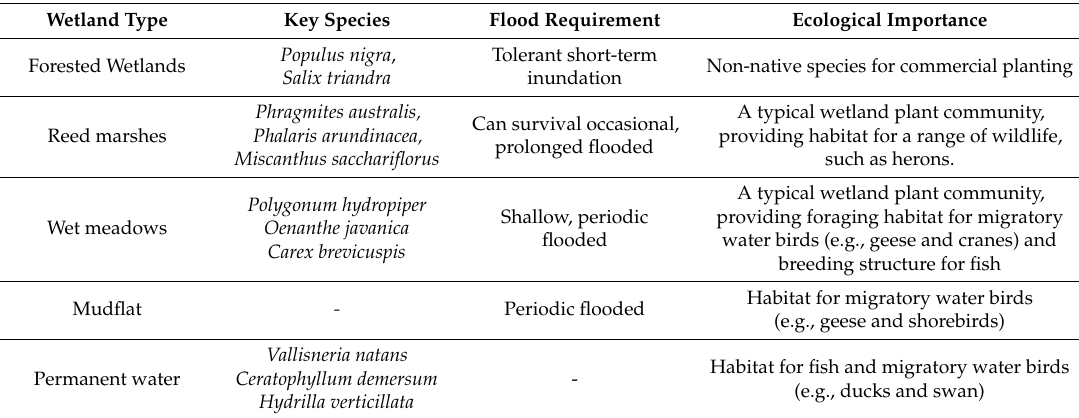
Table 1. Main wetland types in Dongting